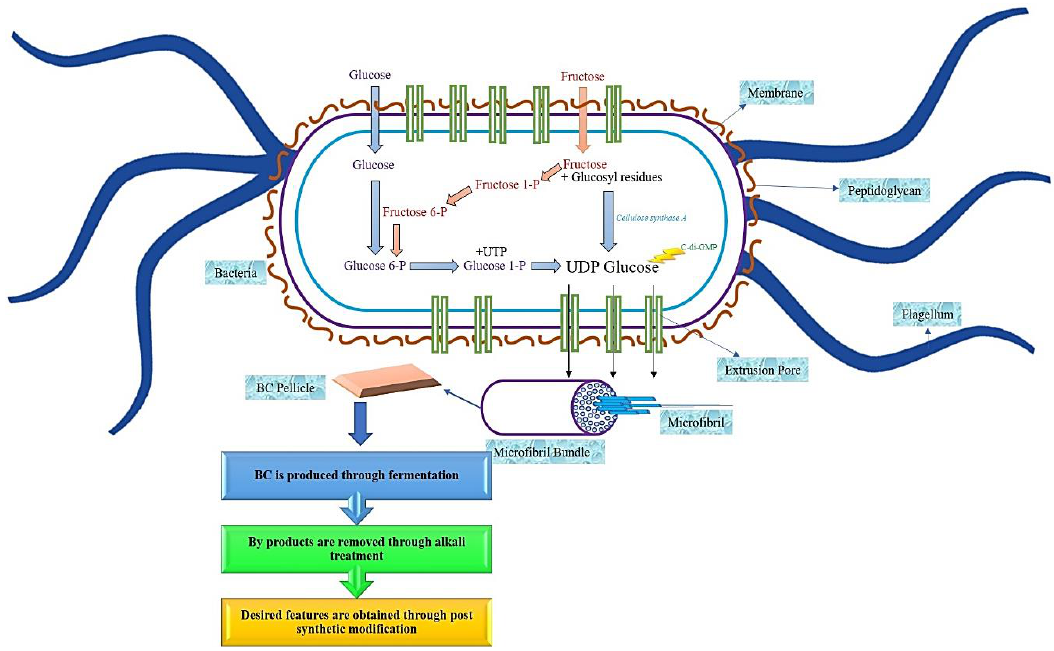
Figure 2. Schematic diagram of bacterial cellulose synthesize.